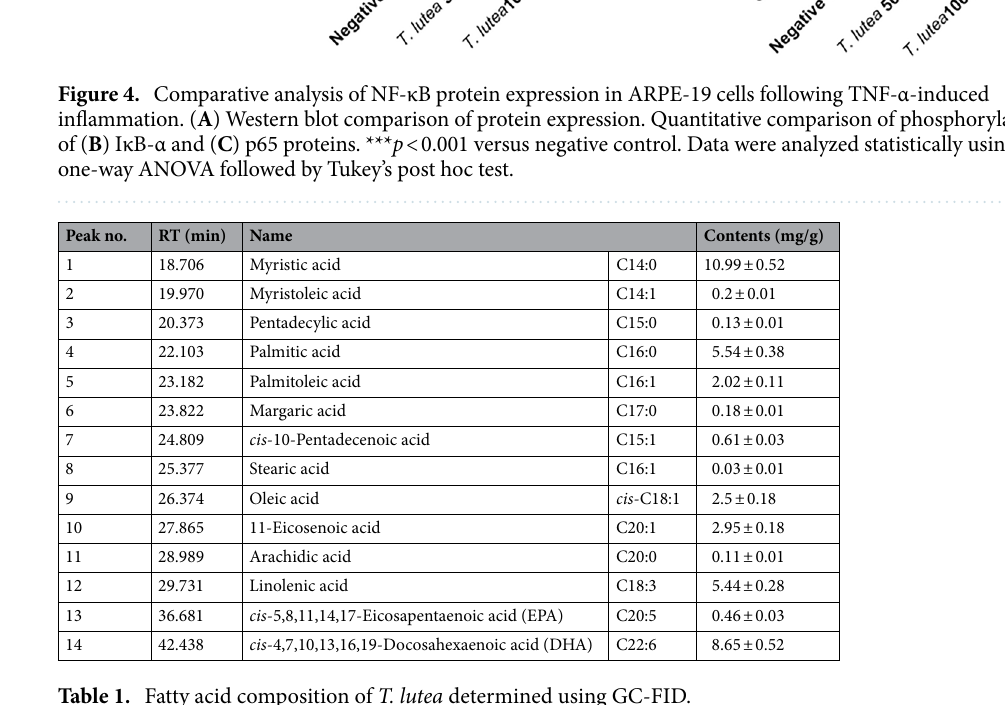
Table 1. Fatty acid composition of T. lutea determined using GC-FID.